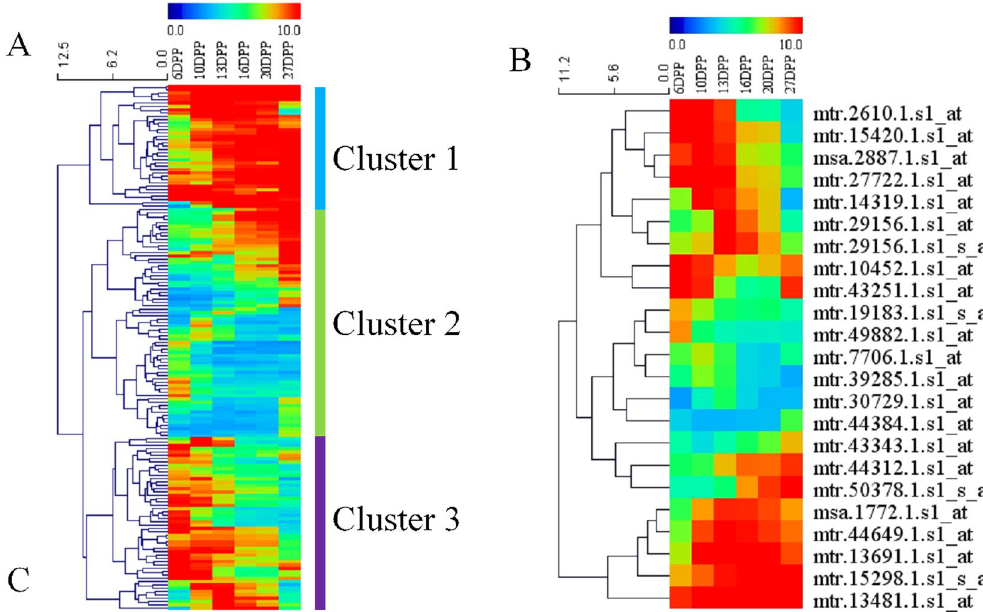
Figure 6. Expression profiling of transport protein genes during MC development. The relative expression values were used to construct the heat map. ( A ) Shows the expression profile of all transport protein genes. ( B ) Is the expression profile of ABC transport protein